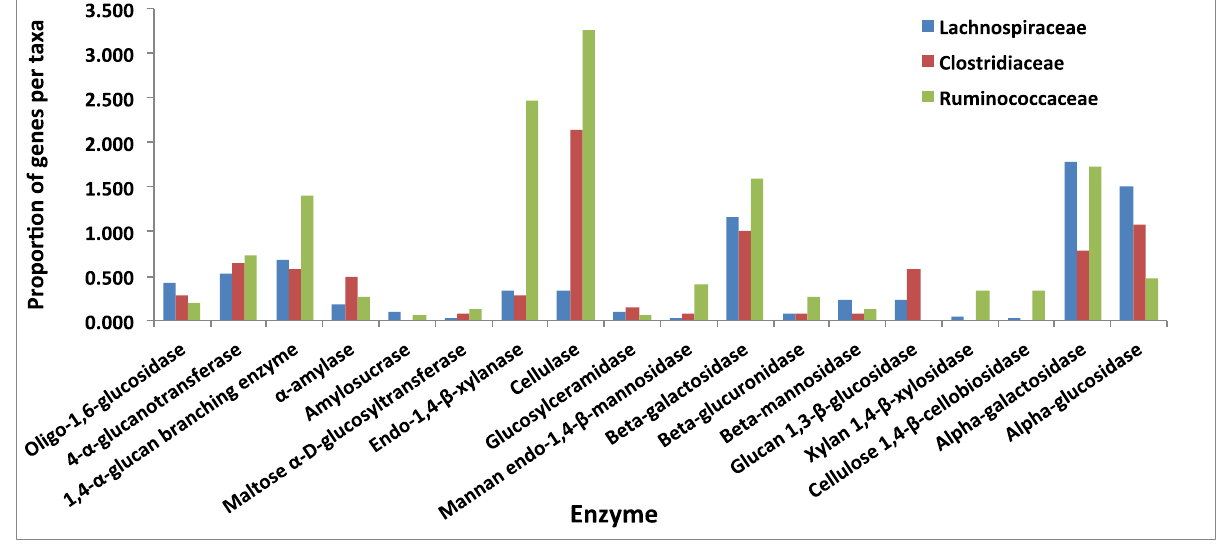
Figure 5. Specific glycoside hydrolase enzymes that differ significantly in abundance between the genomes of Lachnospiraceae, Clostridiaceae, and Ruminococcaceae based on best fit between negative binomial or Poisson regression models (Clostridiaceae as reference) as determined by likelihood ratio test ( p -value < 0.05).